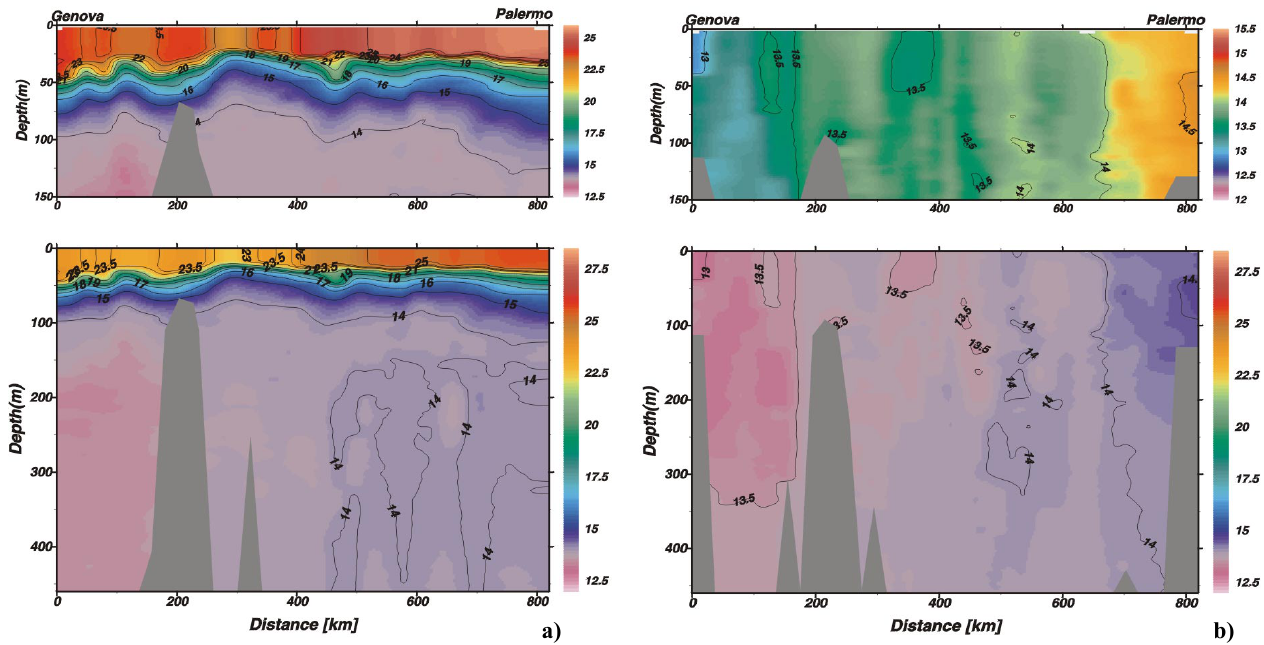
Fig. 4. Temperature vertical sections from Genova to Palermo (track 4) (a) in September 1999 and (b) in February 2000. Numbers indicate the observed features (see also Fig. 1): 3-Liguro-Provenc¸o-Catalan Current, 4-Bonifacio Gyre.